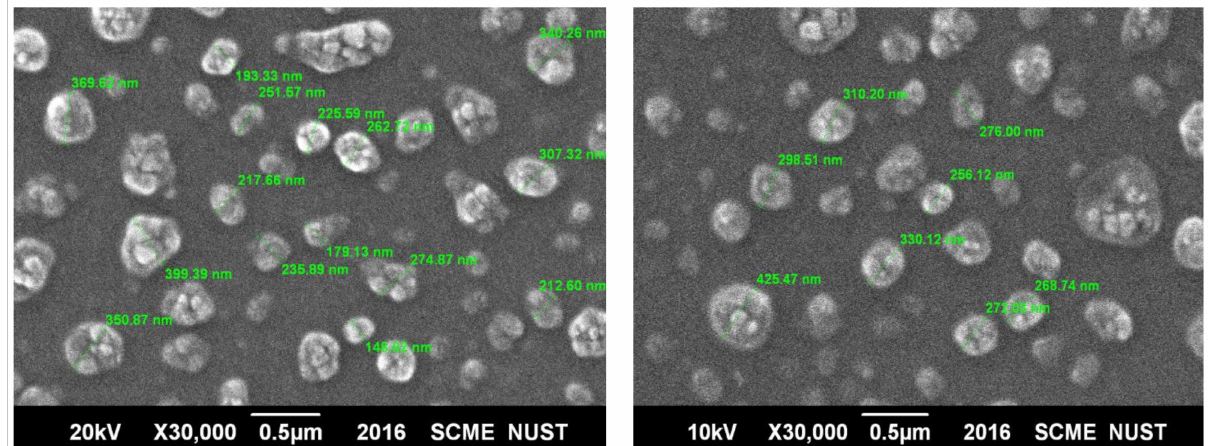
Figure 4. SEM image of RIS-loaded PLGA formulation at different resolutions along with their particle size at 30,000 ×